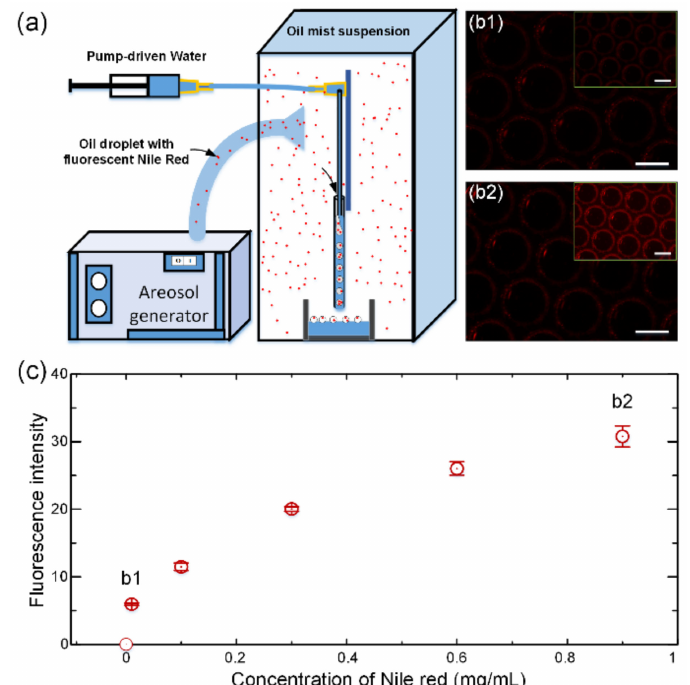
Figure 5. ( a ) Schematics of air detection based on the SPFM method. The fluorescence dye, Nile Red, was suspended in paraffin oil. The suspension was then atomized into a sealed chamber by an aerosol generator. The SPFM device inside the chamber was used to make microbubbles from the air with fluorescence dyed oil mist; ( b1 ) images of microbubbles prepared from oil mist with 0.01 mg/mL Nile Red; ( b2 ) images of microbubbles prepared from oil mist with 0.01 mg/mL Nile Red. The inlets in ( b1 , b2 ) are the same images with 40% brightness and contrast enhancement for better observation in the article. The scale bars are 500 µ m; ( c ) the relationship between the concentration of Nile Red suspended in oil mist and the fluorescence intensity of the microbubbles captured using fluorescent